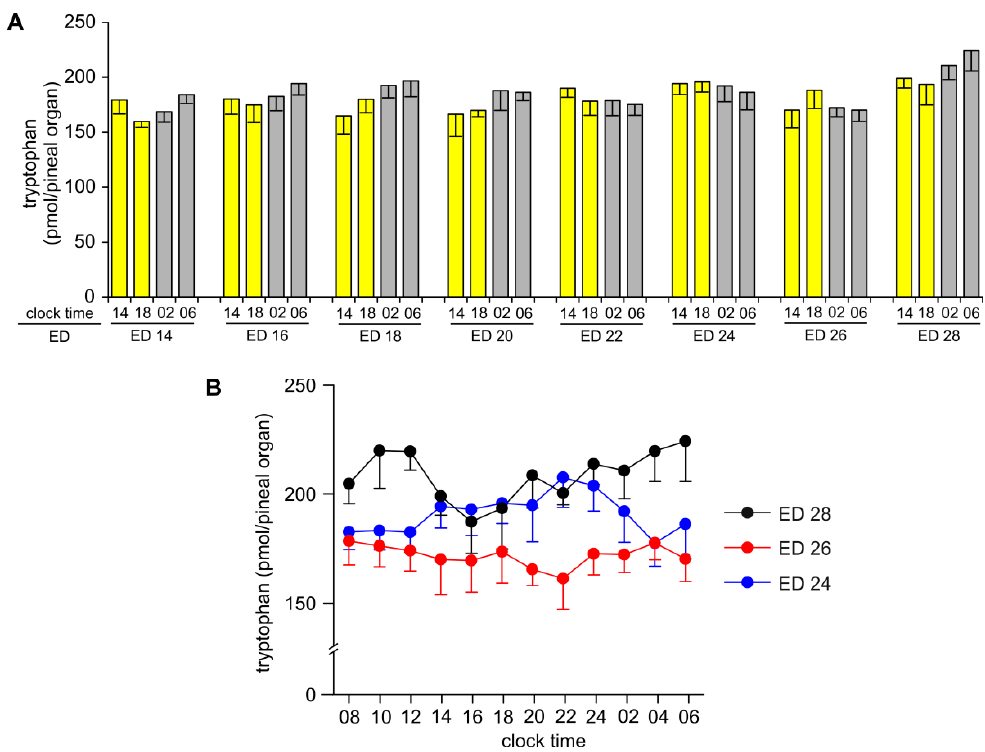
Figure 1. Content (means and SEM, n = 5) of tryptophan in the pineal organs of geese embryos between embryonic day (ED) 14 and ED 28 analyzed at 4 time points per day ( A ) and analyzed at 12 time points per day on ED 24, ED 26, and ED 28 ( B ).